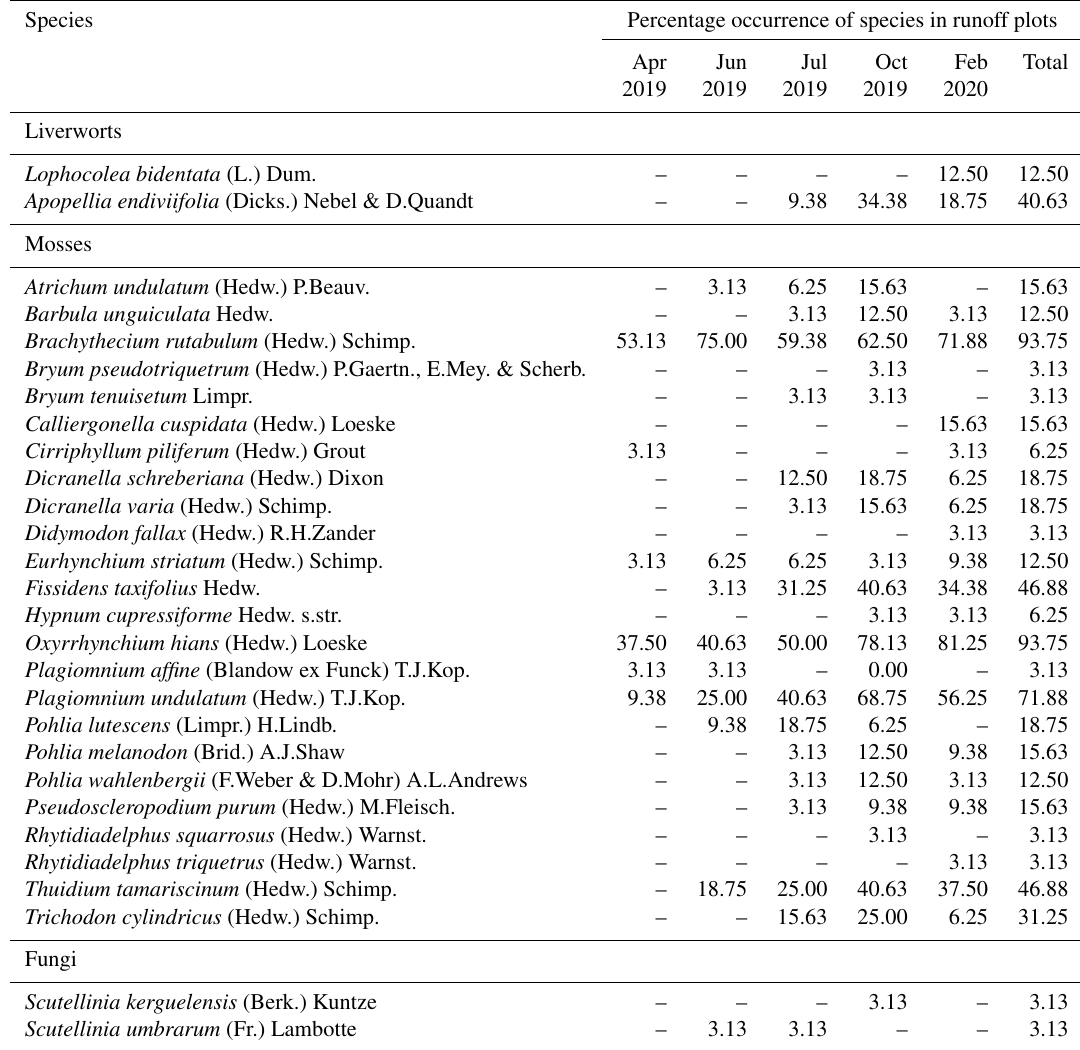
Table 1. Percentage occurrence of bryophyte and fungi species for a total of 32 runoff plots distributed in four skid trails in Schönbuch Nature Park in southwestern Germany, based on five vegetation surveys from April 2019 to February 2020. Species Percentage occurrence of species in runoff